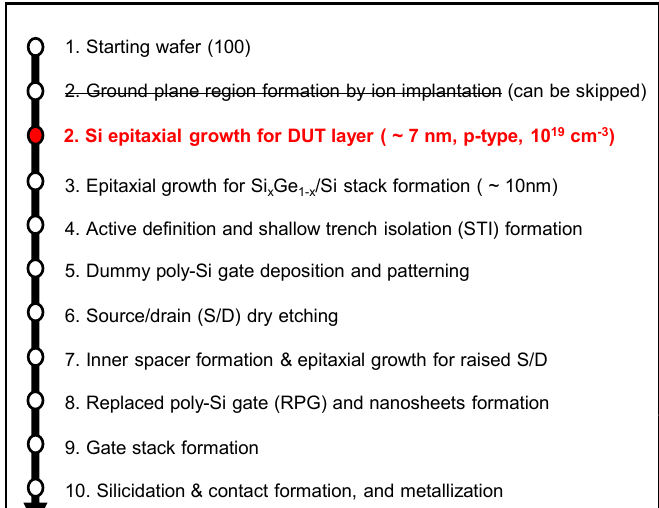
Figure 1. Fabrication process flow of proposed NS FETs including epitaxially grown DUT layer prior to formation of the Si x Ge 1 − x /Si stack. The bolded step two can be alternatively added instead of the under-lined ion implantation and annealing process.